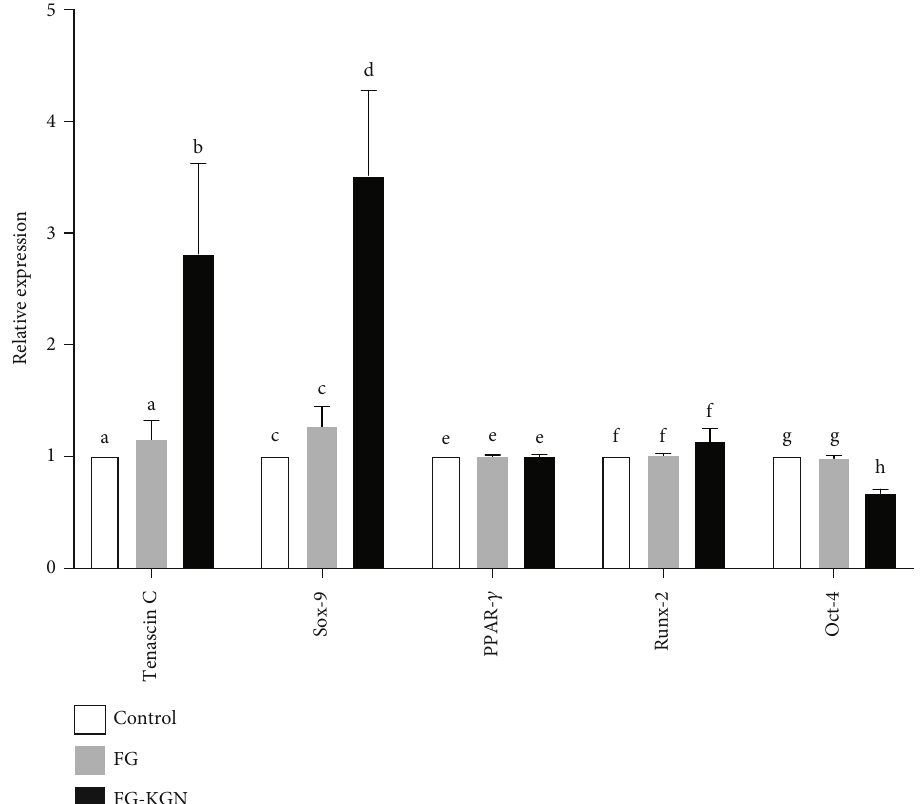
Figure 4: The qRT-PCR results. The expression levels of Tenascin C and Sox-9 was were highly elevated in SMSCs treated with the FG-KGN complex, and were more than twice compared to those in the other two groups (P < 0.01). The expression levels of Oct-4 in the FG-KGN group wereas signi fi cantly lower than that those in the other two groups, which indicated that SMSCs were di ff erentiated after treatment with FG- KGN. (P < 0.01). No signi fi cant di ff erences were observed in tThe expression levels of PPAR- γ and Runx-2 were observed non signi fi cant di ff erence between the FG-KGN treatment group and the other onesgroups (P >